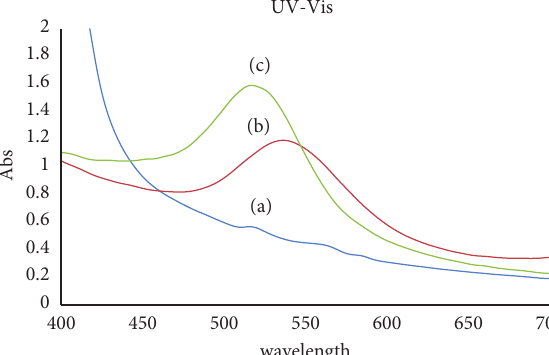
Figure 3: UV-Vis absorption spectra of okra extract (a), Au NPs synthesized from okra (Ok Au NPs) (b), and a solution containing Ch Au NPs (chemical synthesis)